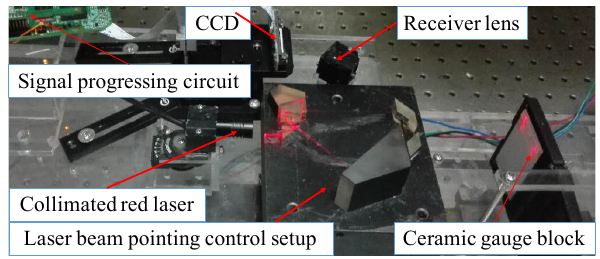
Figure 5. Reduction of the influence of laser beam directional dithering in a laser triangulation displacement probe.